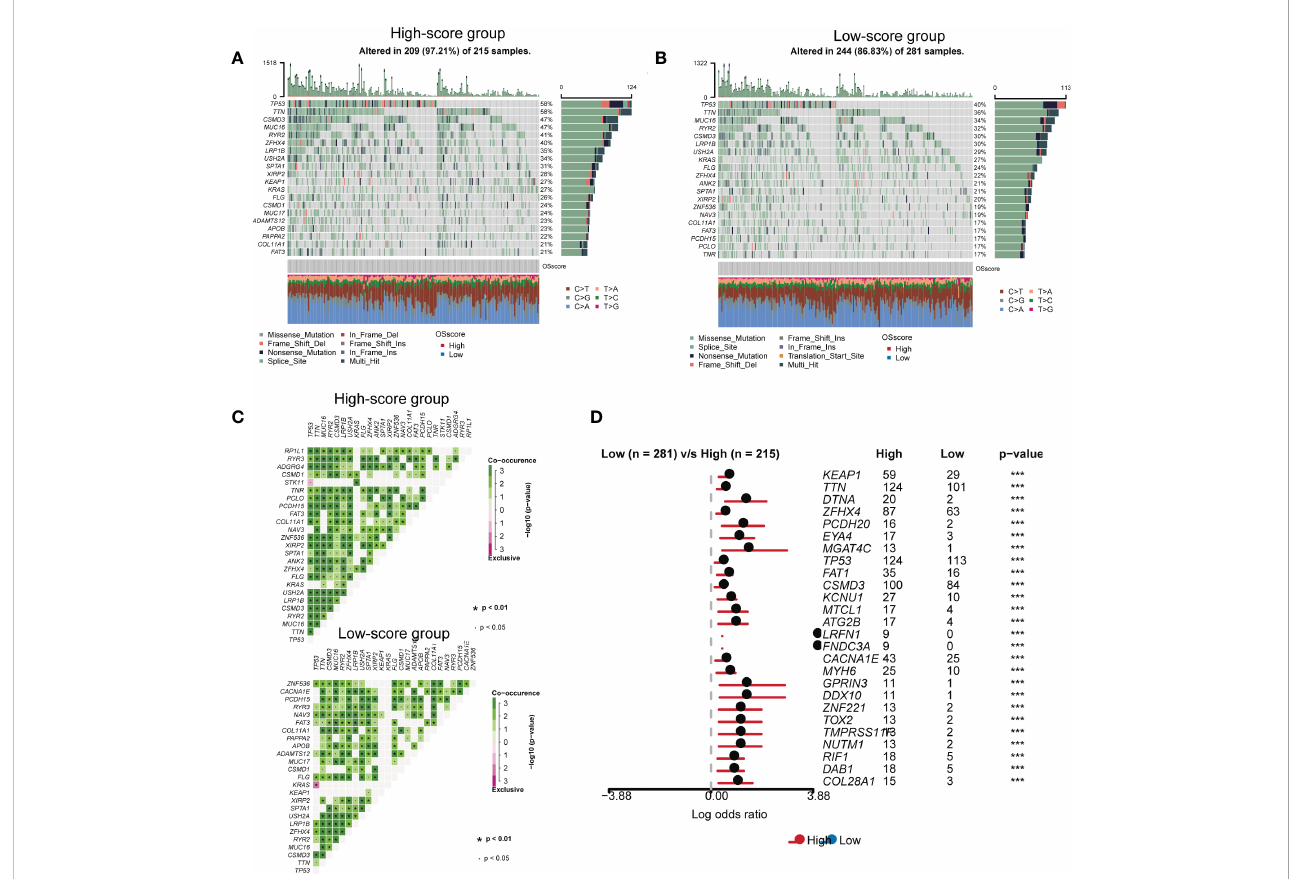
FIGURE 4 The somatic mutation features of the established OS-signature for LUAD. (A, B) The waterfall plot of somatic mutation features established with high (A) and low (B) OS-score. (C) We performed Pair-wise Fisher ’ s Exact test to detect mutually exclusive or co-occurrence events. (D) Forest plot for mutation differences between